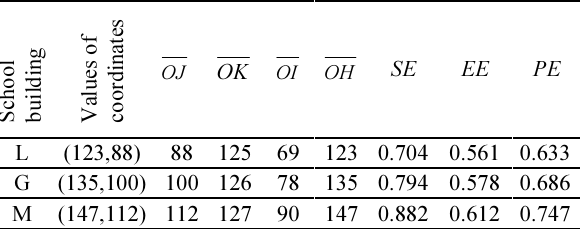
Fig. 8. Calculating planning efficiencies for different school buildings under the same planning preference